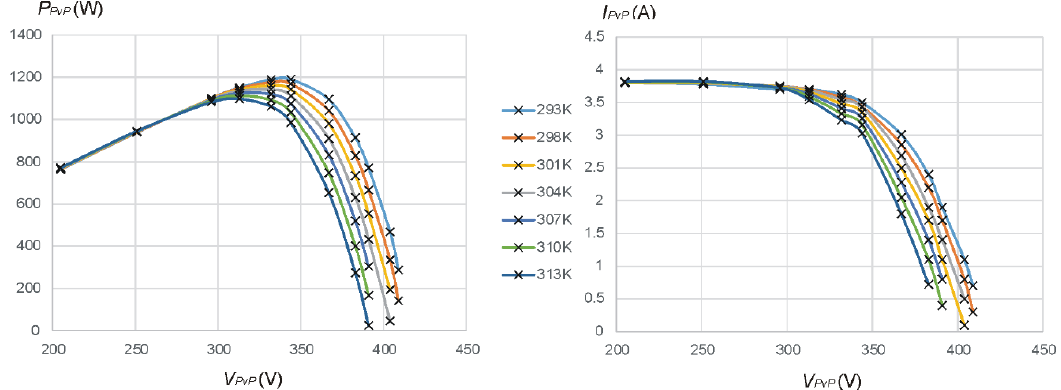
Figure 14. Emulated PvP P-V and I-V characteristics obtained from the laboratory experiment for assumed temperatures in K for constant solar irradiance 1000 W / m 2